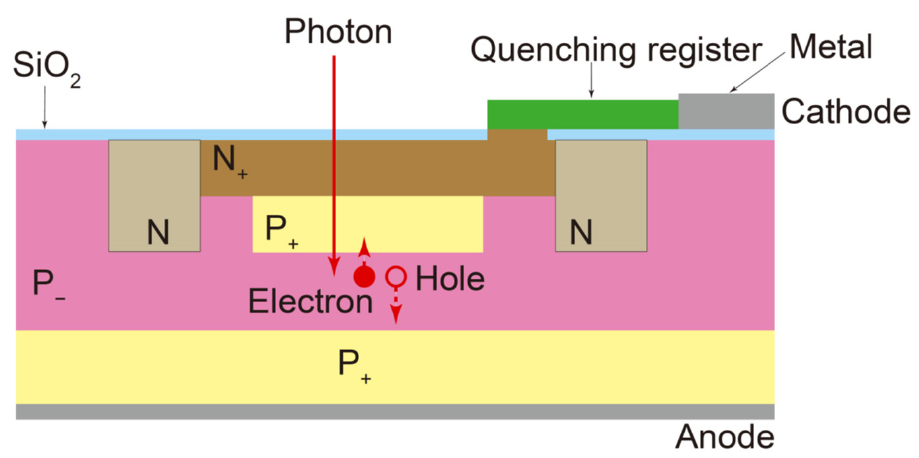
Figure 5. Schematic of a single photon avalanche diode (SPAD).